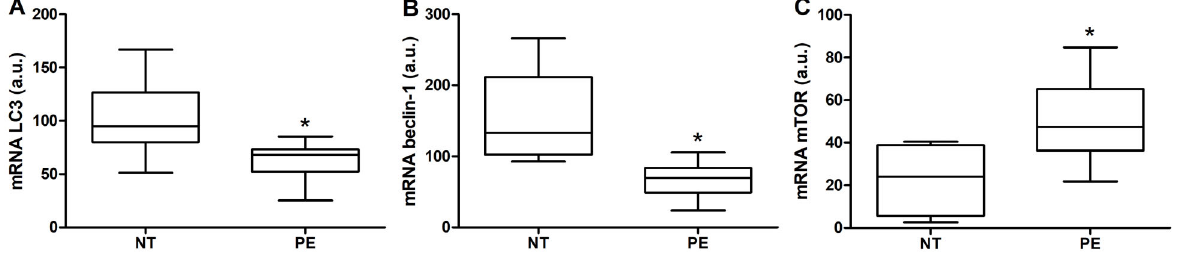
Figure 1. Gene expression of LC3 ( A ), beclin-1 ( B ), and mTOR ( C ) in placental tissues from 20 normotensive pregnant women (NT) and 20 pregnant women with preeclampsia (PE). Results are reported as median (horizontal line), 25th and 75th percentiles (box) and range (whiskers). *P o 0.05 vs NT (Mann-Whitney U test). a.u.: arbitrary